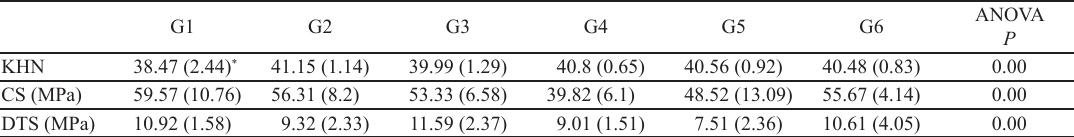
Table 2 - Results of KHN, CS, and DTS of each group.